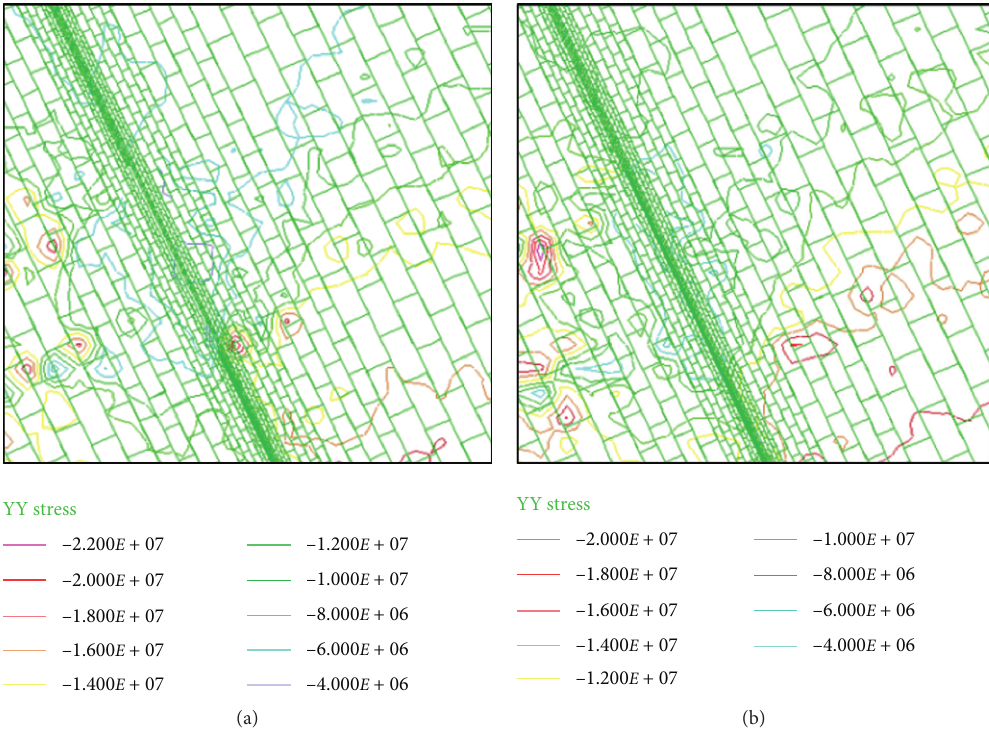
Figure 11: Surrounding rock vertical stress distribution with 110m stope height. (a) Caving. (b) Backfilling.